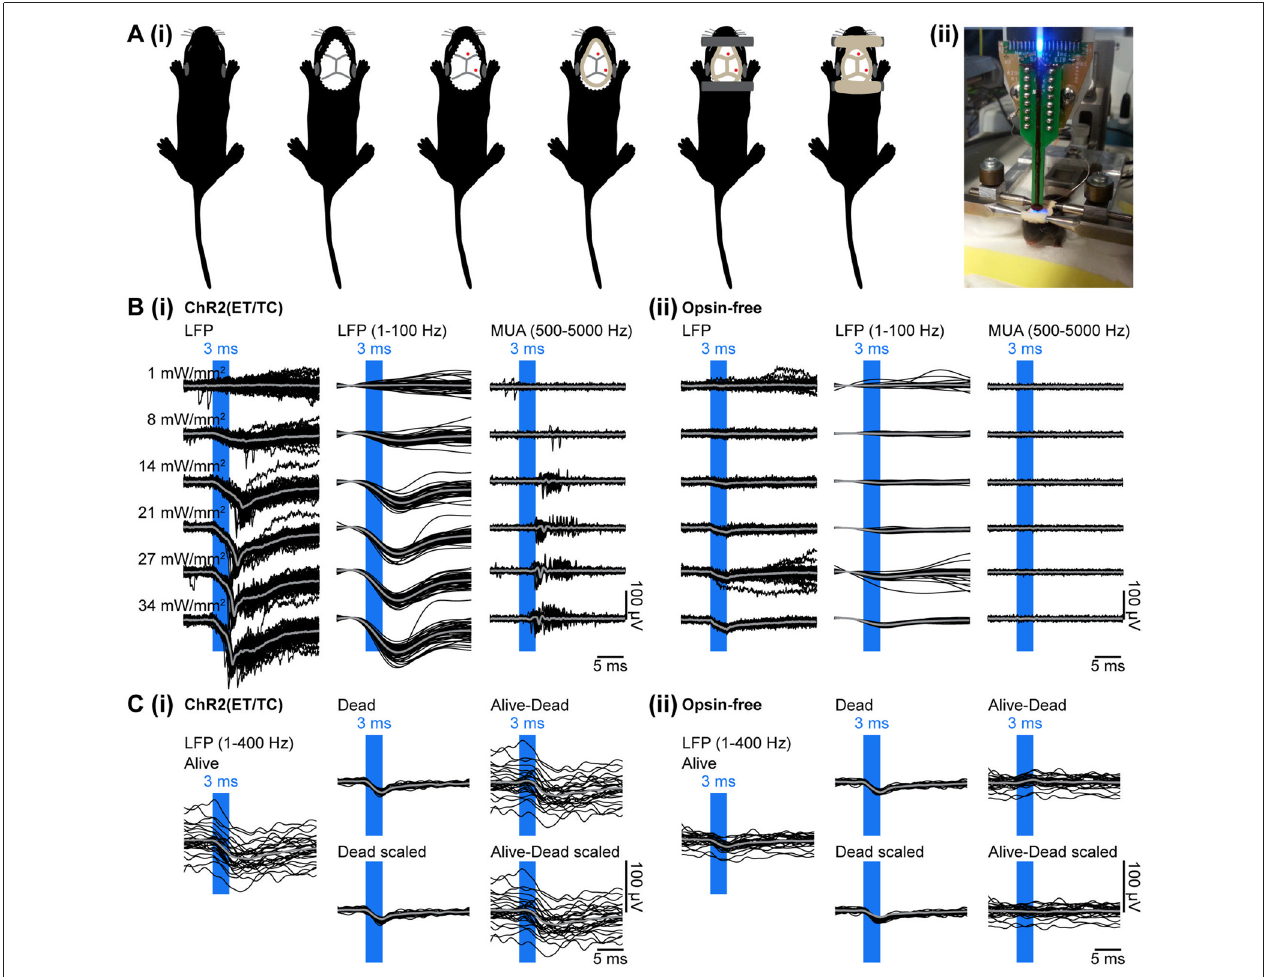
FIGURE 3 | Combined light stimulation and multi-site extracellular recordings from the PFC of neonatal mice in vivo . (Ai) Diagrams illustrating the surgery for electrophysiology in vivo in neonatal mice. The skin is removed from the top of the head and dental cement is applied to strengthen the fragile skull and serve as “glue” for two plastic tubes that enable head fixation. (ii) Photograph showing a head-fixed P10 mouse during combined light stimulation and extracellular recordings in vivo . (Bi) Extracellular recordings (unfiltered local field potentials (LFP), band-pass filtered LFP and MUA) from the PFC of a P10 mouse transfected with ChR2(ET/TC) by IUE at E15.5 in response to light pulses (473 nm, 3 ms) of different intensities. (ii) Same as (i) for a mouse transfected with an opsin-free construct. (Ci) Representative band-pass filtered (1–400 Hz) LFP signals recorded in response to 30 trains of pulsed stimuli (473 nm, 3 ms, 14 mW/mm 2 ) before (Alive) and after a lethal injection of ketamine-xylazine (Dead, Dead scaled) from a neonatal mouse transfected by IUE with ChR2(ET/TC). The LFP trace after removal of photoelectric artifacts was obtained by subtraction of the scaled artifact (Alive-Dead scaled). (ii) Same as (i) for an opsin-free mouse. For (B,C) individual traces are shown in black, averages are shown in